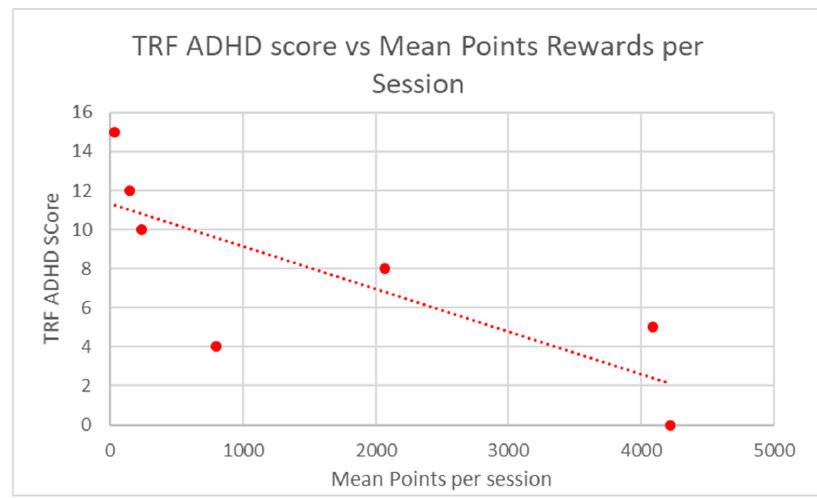
Figure 5. TRF ADHD score vs. Mean Star Rewards per Figure 4. TRF ADHD score vs Mean Star Rewards per Session.